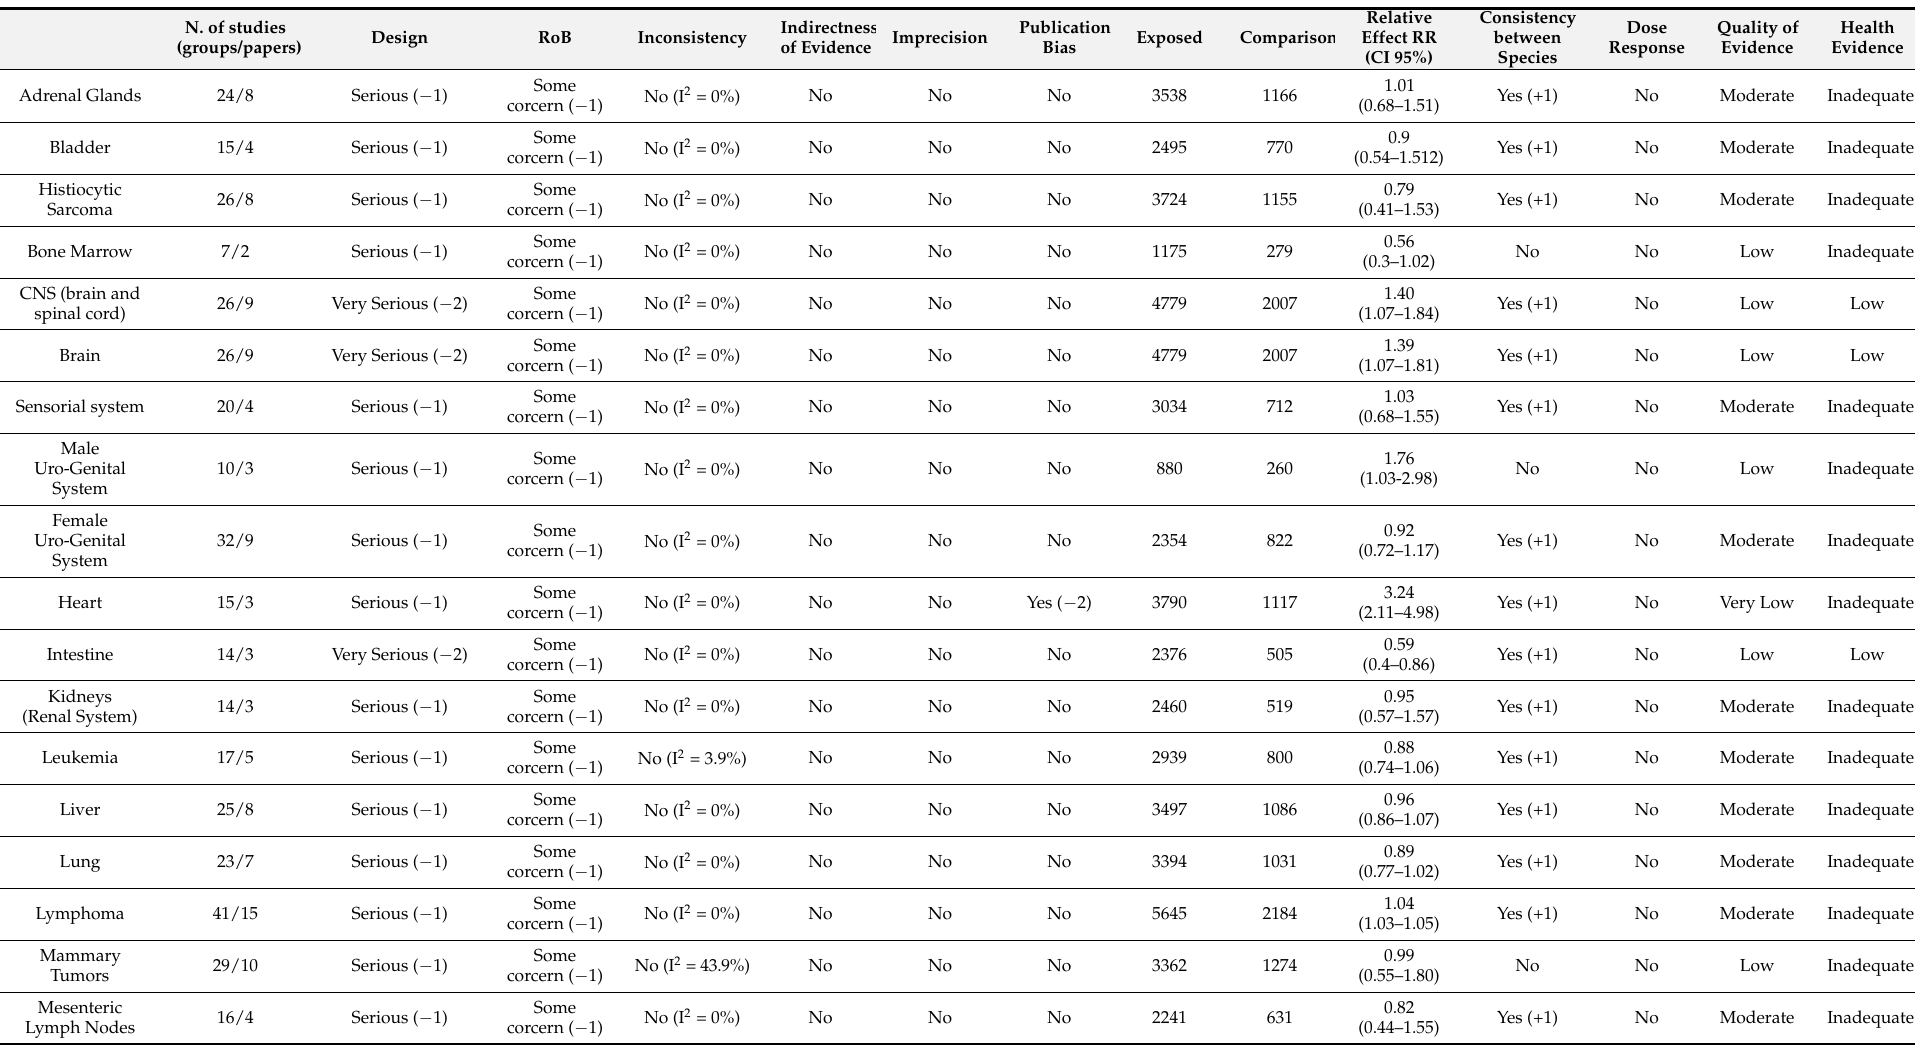
Table 10. Quality Assessment for the results on malignant tumors in selected